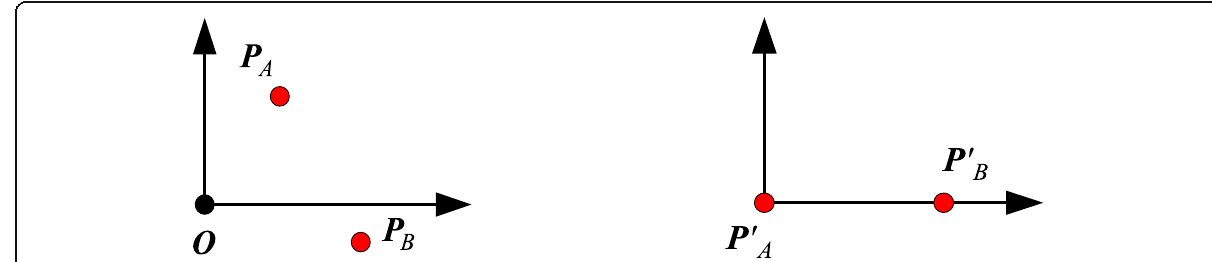
Fig. 3 Pre-transformation of arbitrary given endpoints such that P ' A = (0, 0) T and P ' A P ' B denotes the positive direction of the x axis. This is essentially just a transformation of the local coordinate system. a : Arbitrary given endpoints; b : After